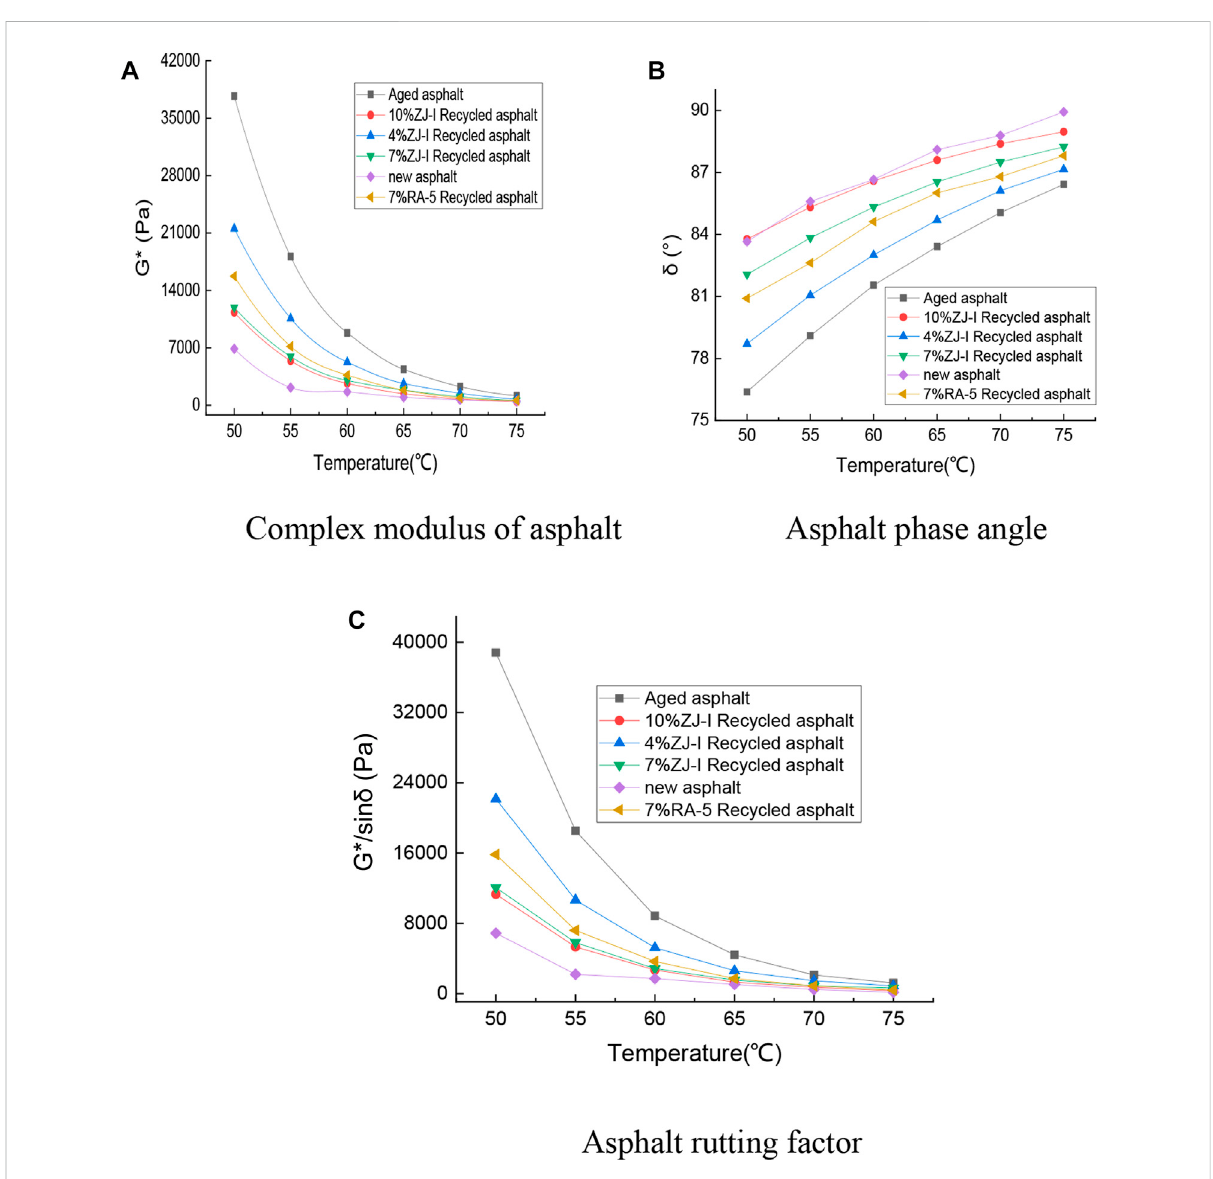
FIGURE 8 High-temperature rheological index of